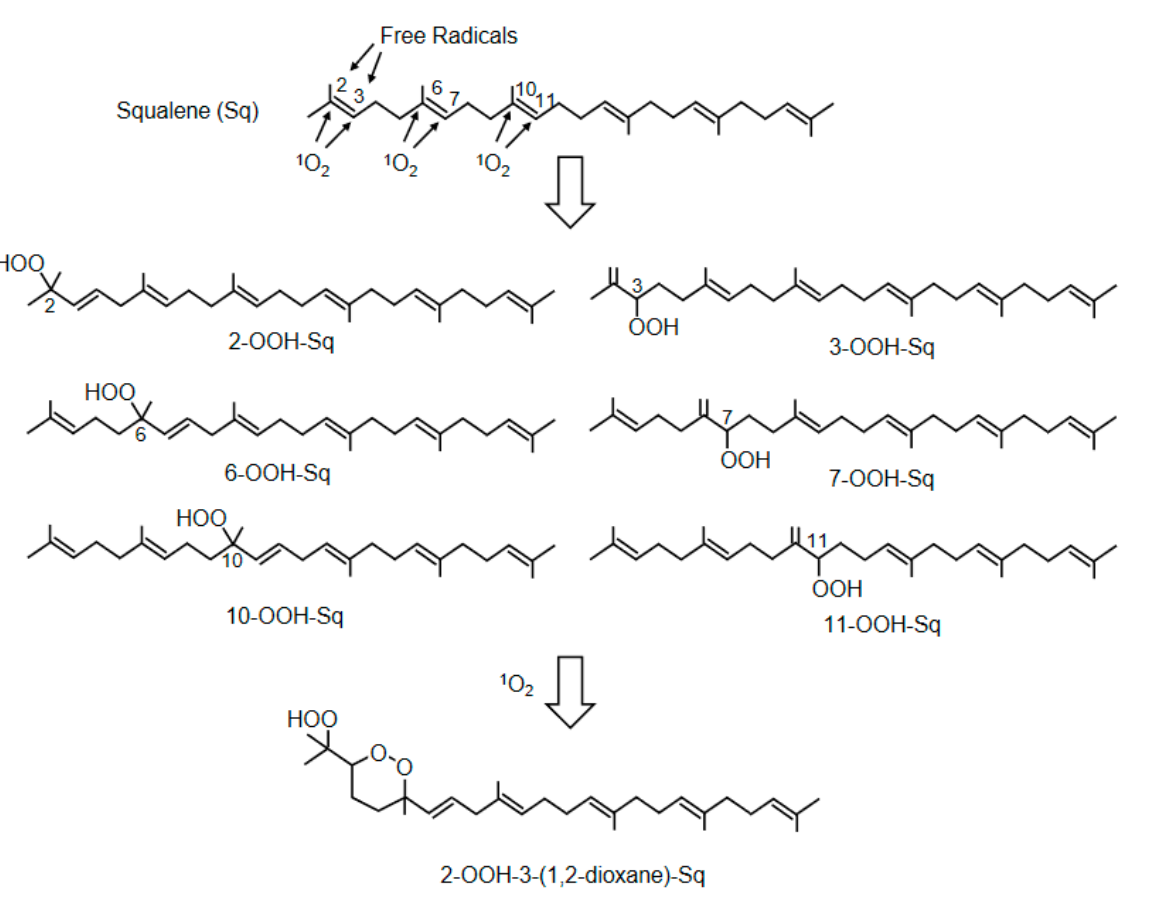
Figure 9. The structures of squalene and its peroxidation products. Squalene (Sq) is converted by 1 O 2 to six monohydroperoxides (2-, 3-, 6-, 7-, 10-, and 11-OOH-Sq). The monohydroperoxides of Sq are further photo-oxidized to